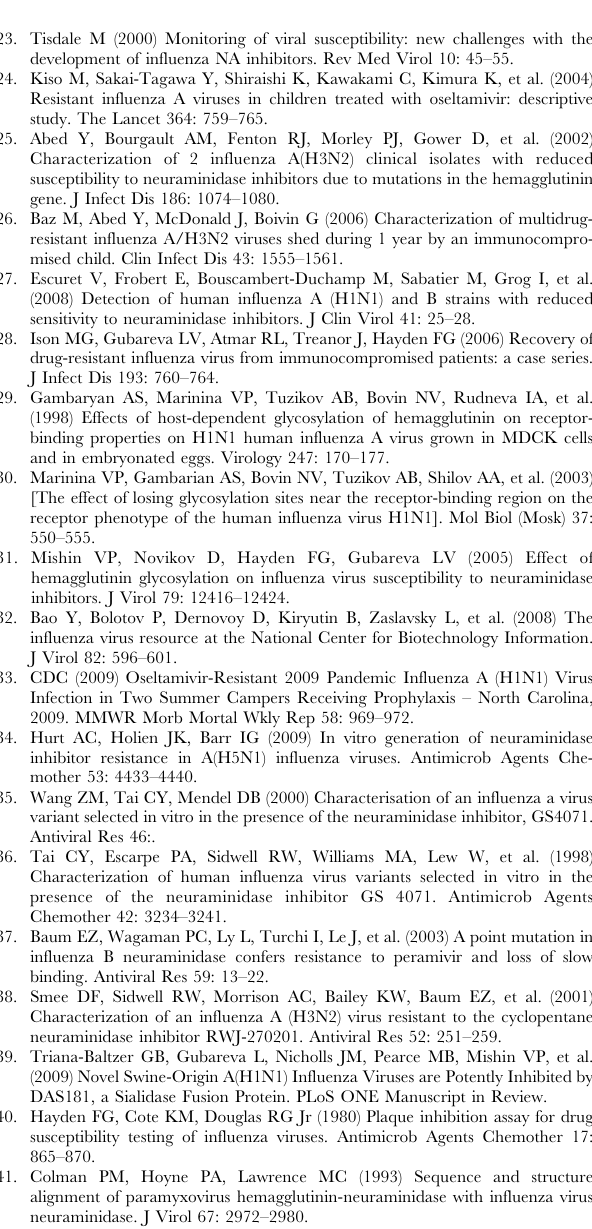
Figure S6 HA alignment of recently published H1N1 IFV isolates. Published HA sequences for several 2007/2008 isolates were aligned with Clustal W2 software to determine the conservation of amino acid choice at select regions identified as mutations in Figure S3. Sequence data noted with H3 numbering scheme, as previously described [42]. Highlighted residues correspond to: Red=N163, Green=G/V189, Blue=D225. *=identical amino acid, : =highly similar amino acid, . =moderately similar amino acid.